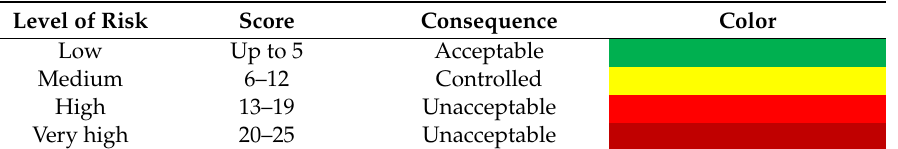
Table 3. Categories and numerical values of risk.